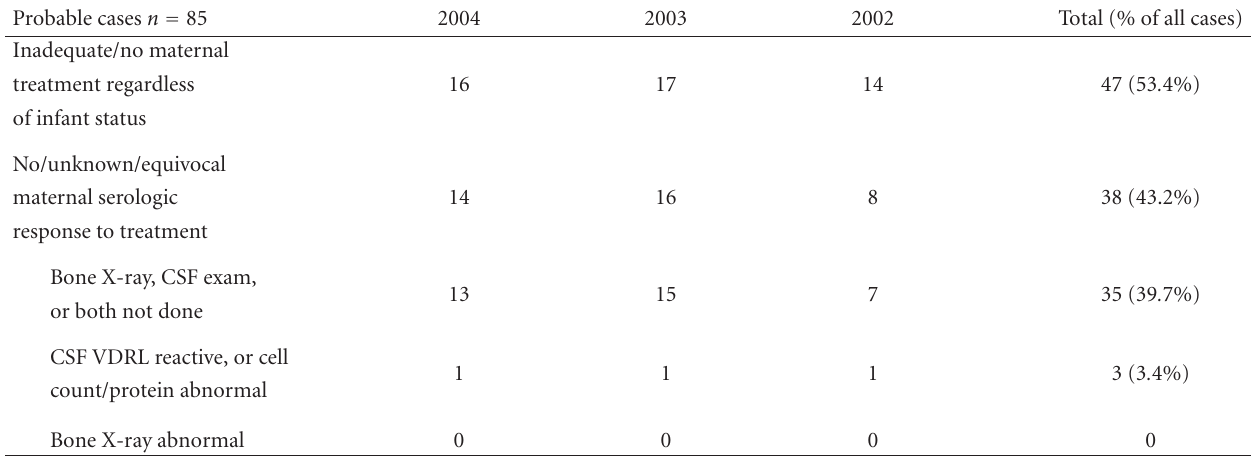
Table 2: Probable congenital syphilis cases in Detroit during years 2002–2004.